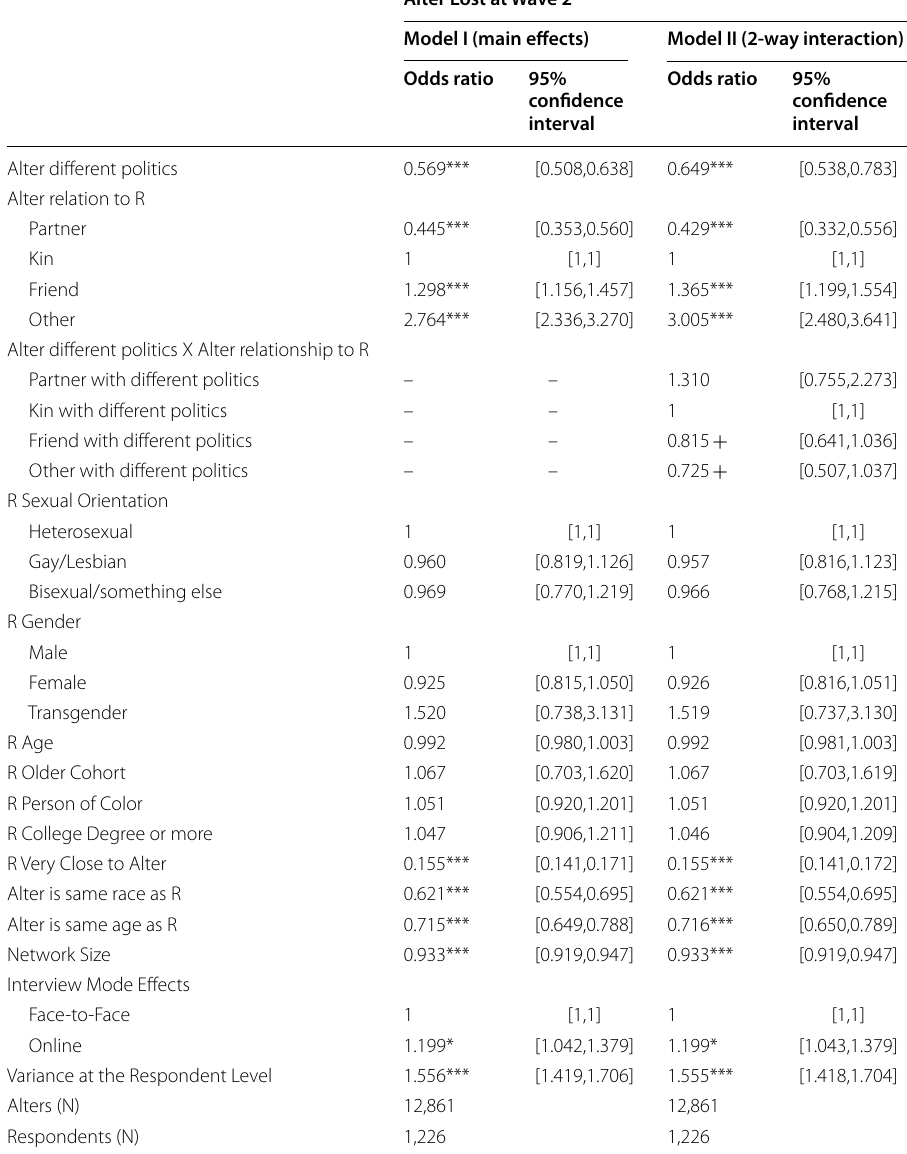
Table 5 Estimates of the likelihood of alter loss at Wave 2 by political views and relationship to respondent,